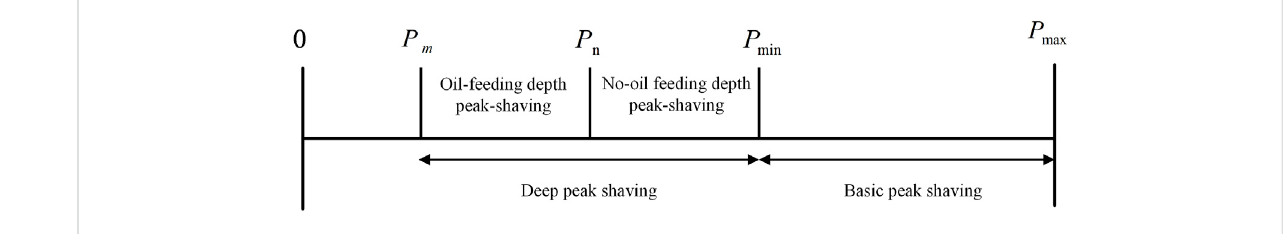
FIGURE 3 Schematic diagram of the peak shaving stage of thermal power